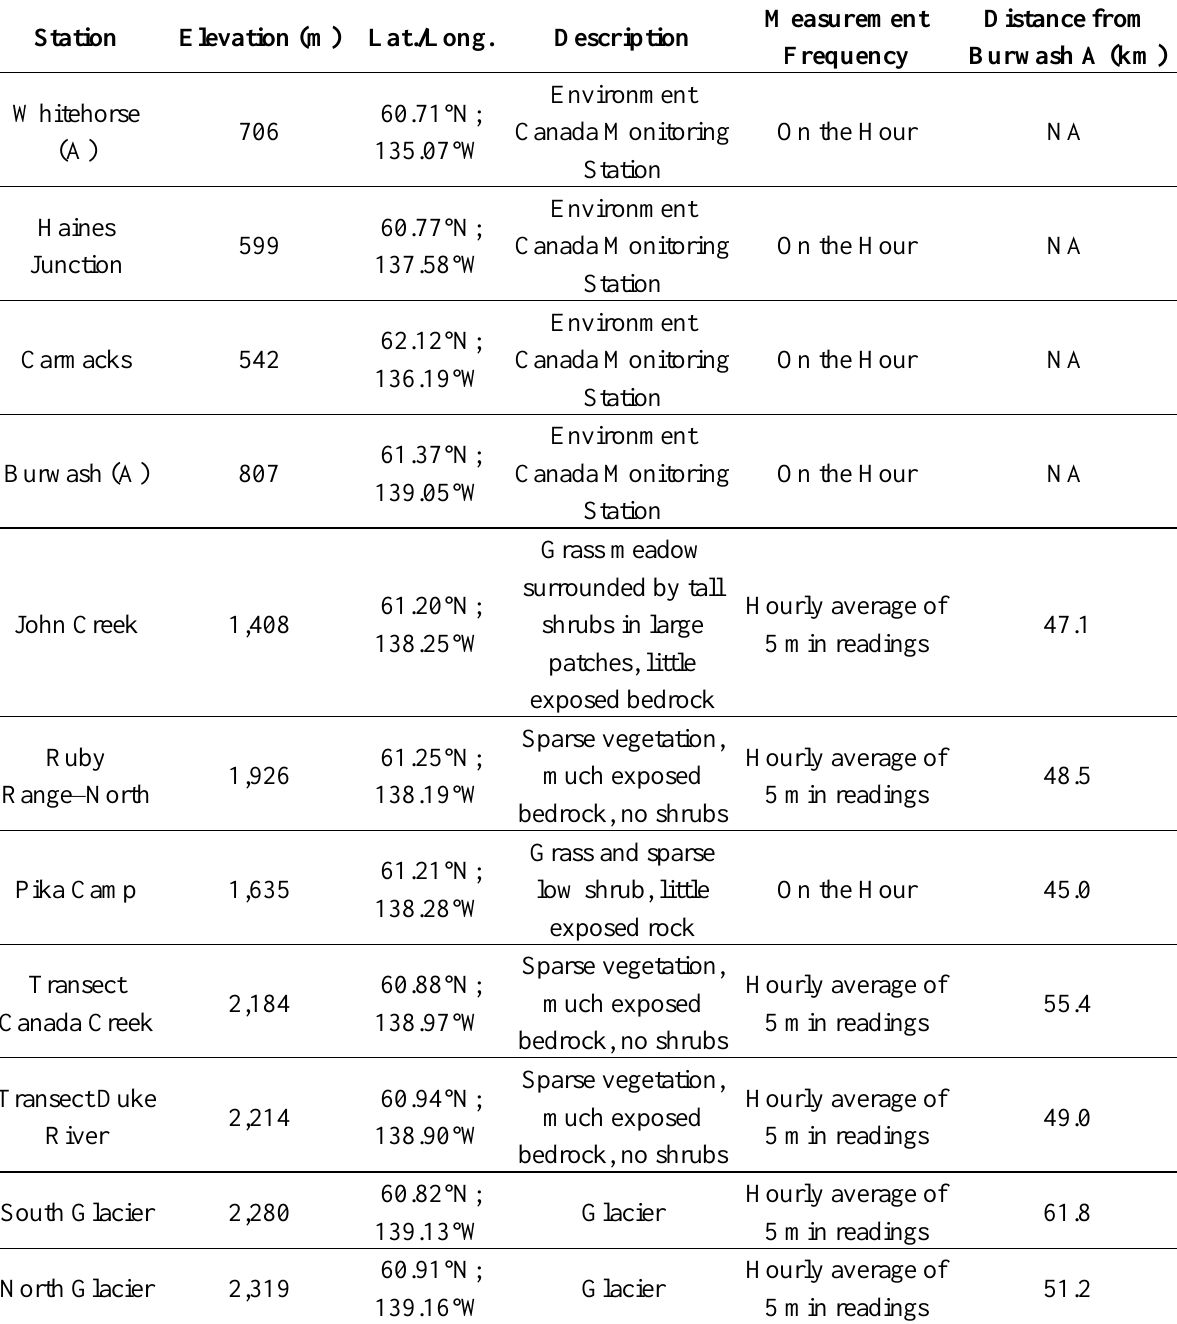
Table 1. Description and location of meteorology stations in southwest